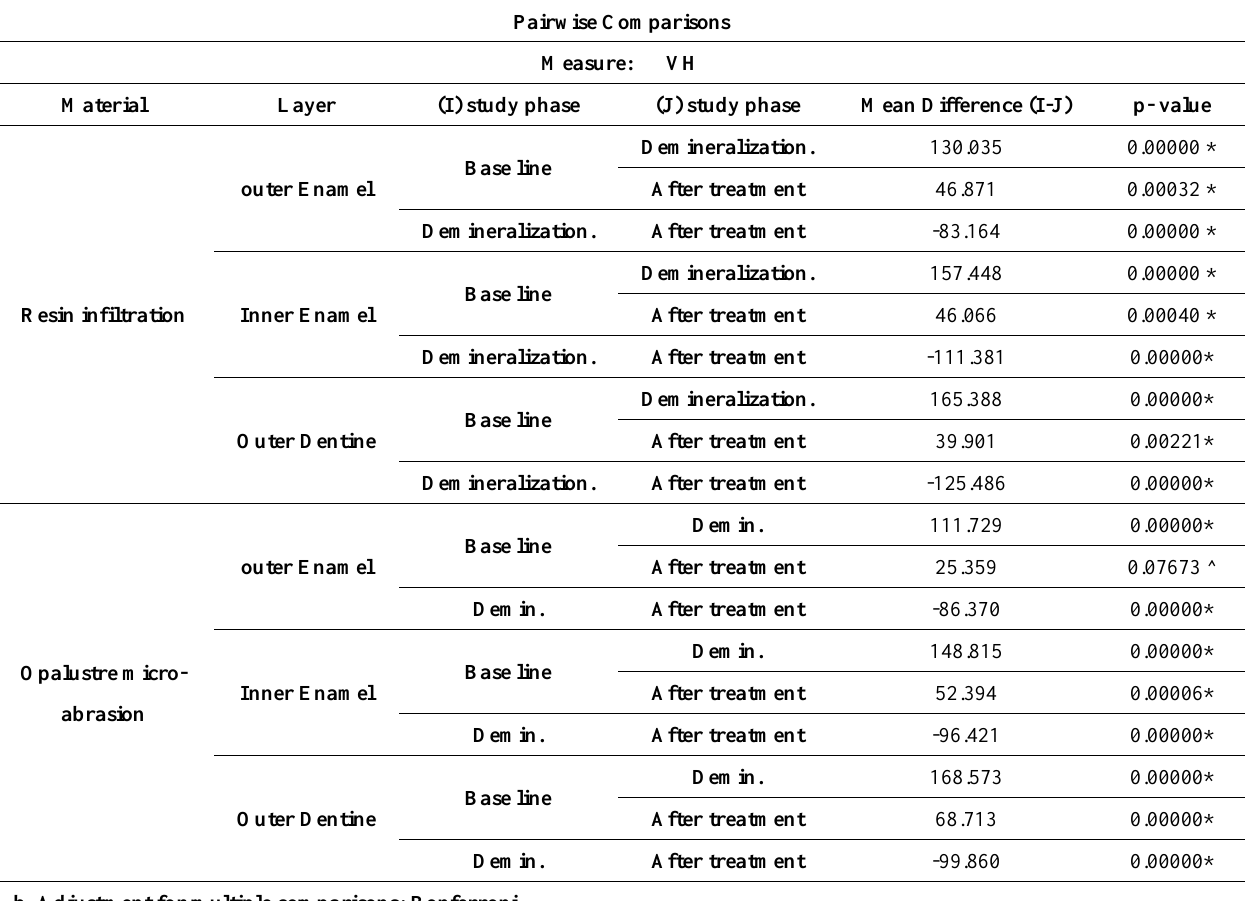
Table 2: Multiple comparisons of microhardness unit (VHN) between different study phases according to lesion depth and study